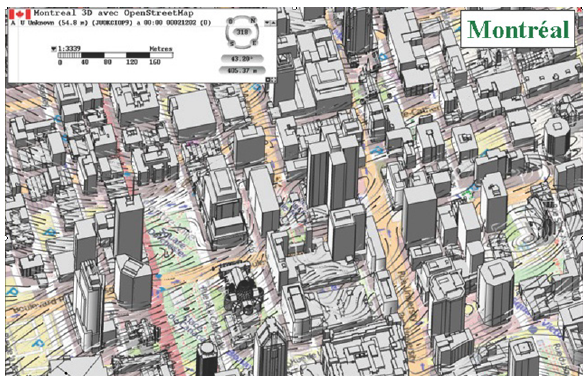
Figure 8. The 3D map well represents measurements results, and particularly the mitigation by trees vegetation to surface